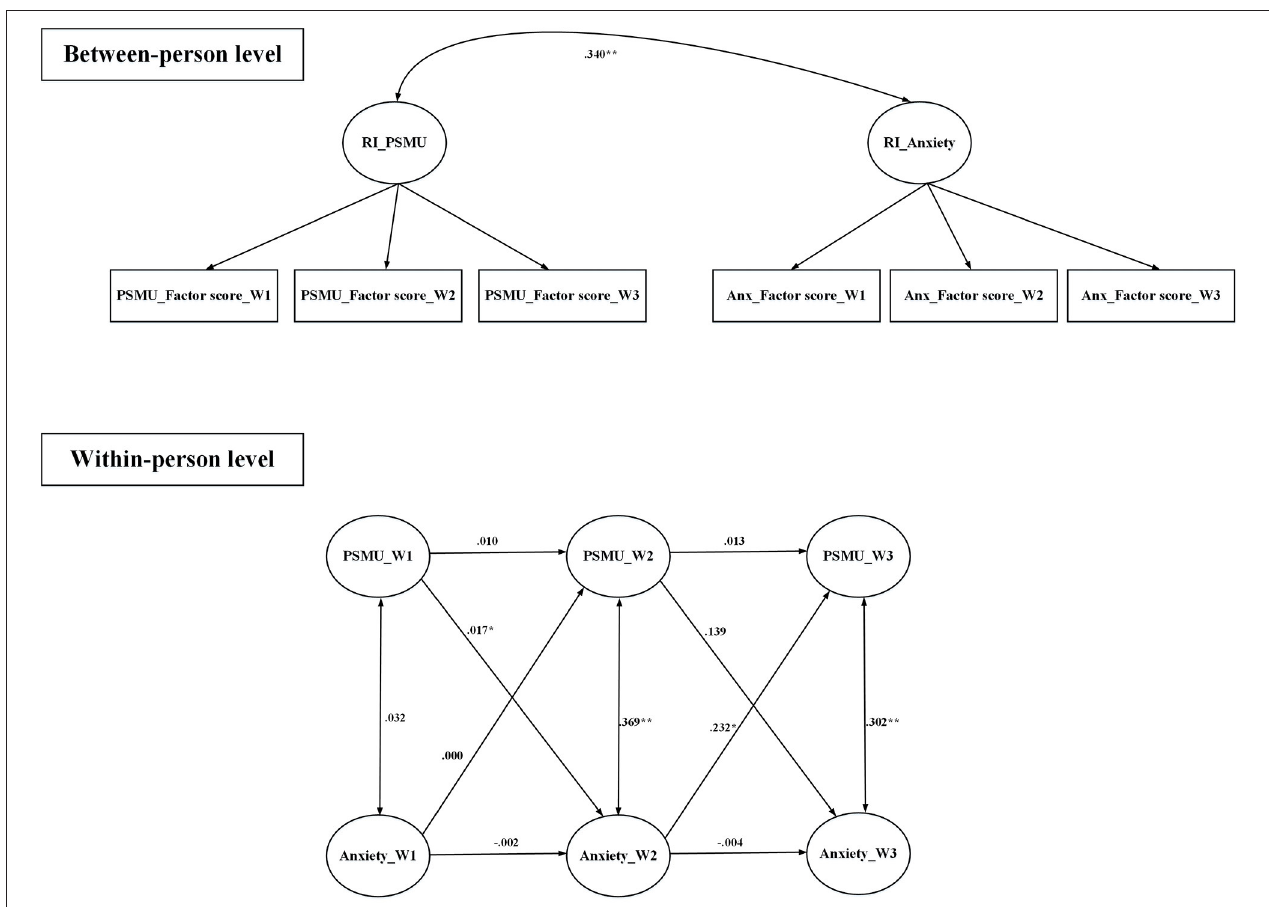
FIGURE 1 | Cross-lagged model of PSMU and anxiety using lagged bidirectional model. Covariates include gender and age. Anxiety was assessed using the Hospital Anxiety and Depression Scale; PSMU, problematic social media use was assessed using the Bergen Social Media Addiction Scale. RI, random intercept; W1, wave 1; W2, wave 2; W3, wave 3. All the estimates are standardized coefficients. * p < 0.05; ** p < 0.01.